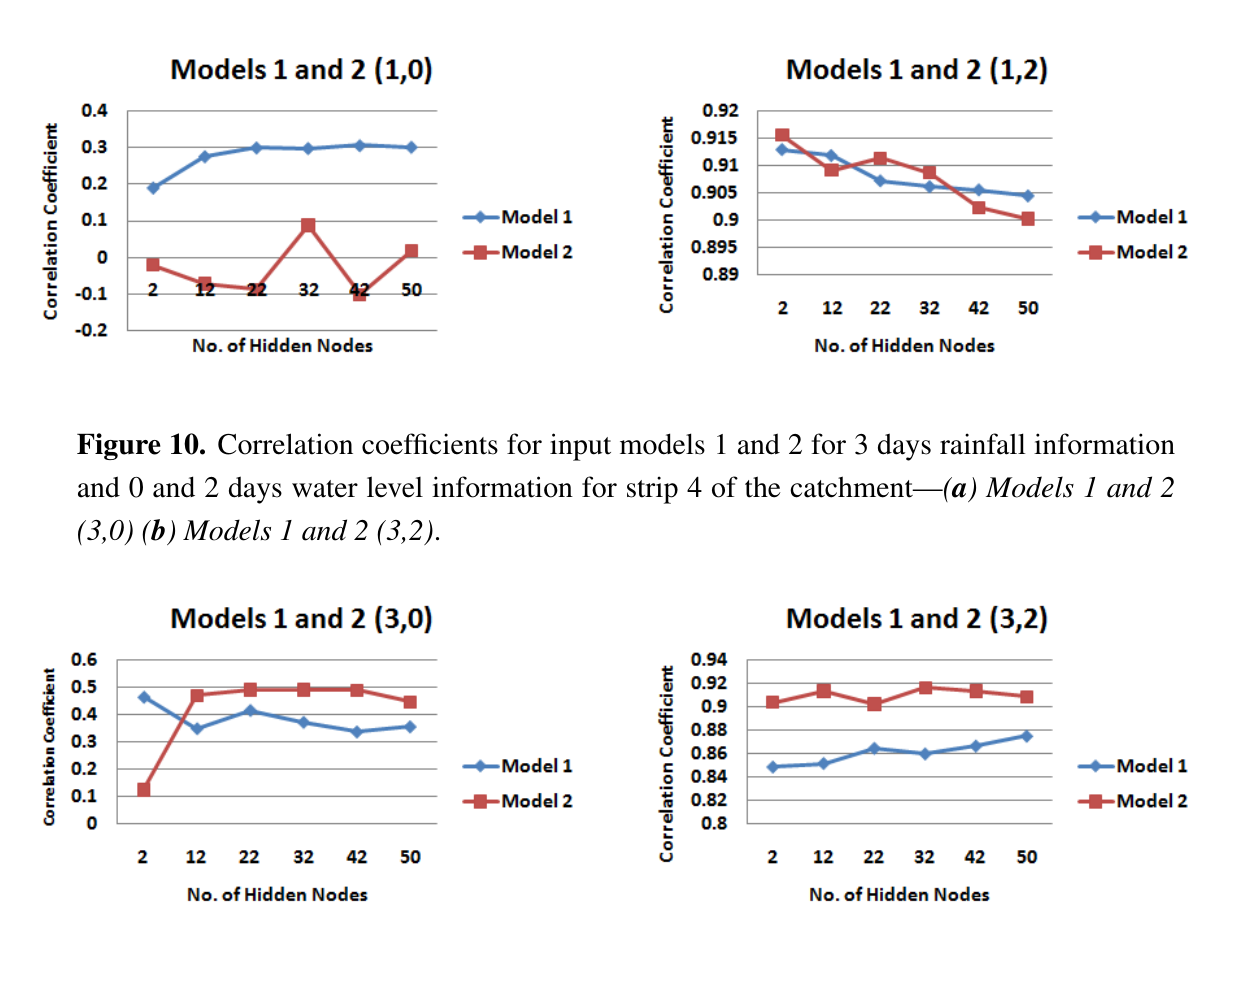
Figure 11. Correlation coefficients for input models 1 and 2 for 5 days rainfall information and 0 and 2 days water level information for strip 4 of the catchment— ( a ) Models 1 and 2 (5,0) ( b ) Models 1 and 2 (5,2)